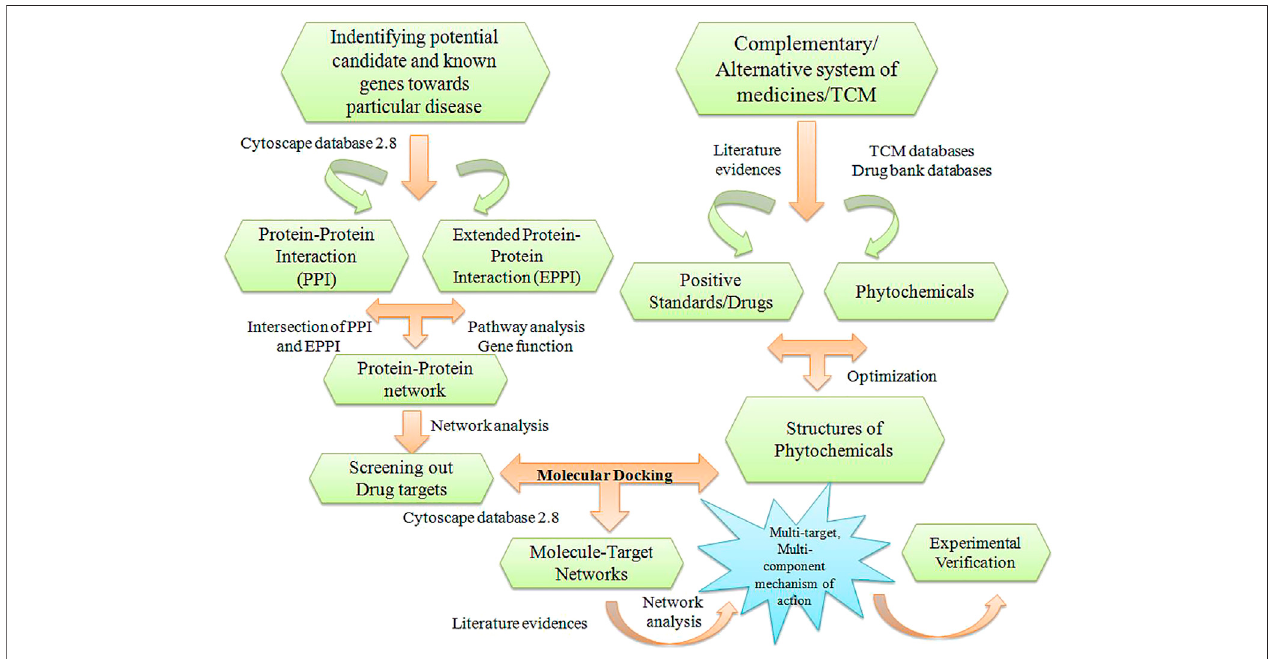
FIGURE 14 | Schematic representation of network pharmacology